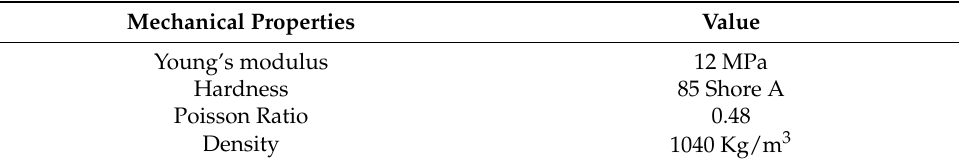
Table 1. Mechanical properties of NinjaFlex ®